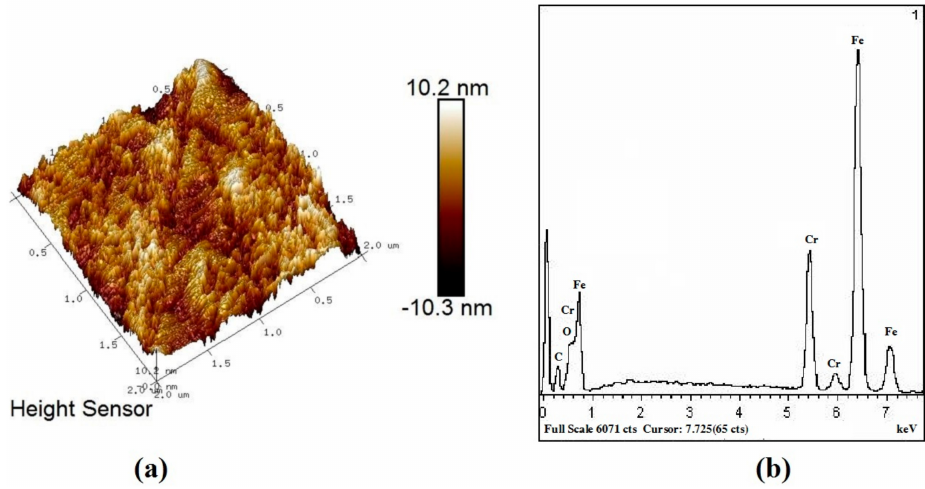
Figure 4. ( a ) 3D AFM image; ( b ) EDS Energy Spectrumof the 2#